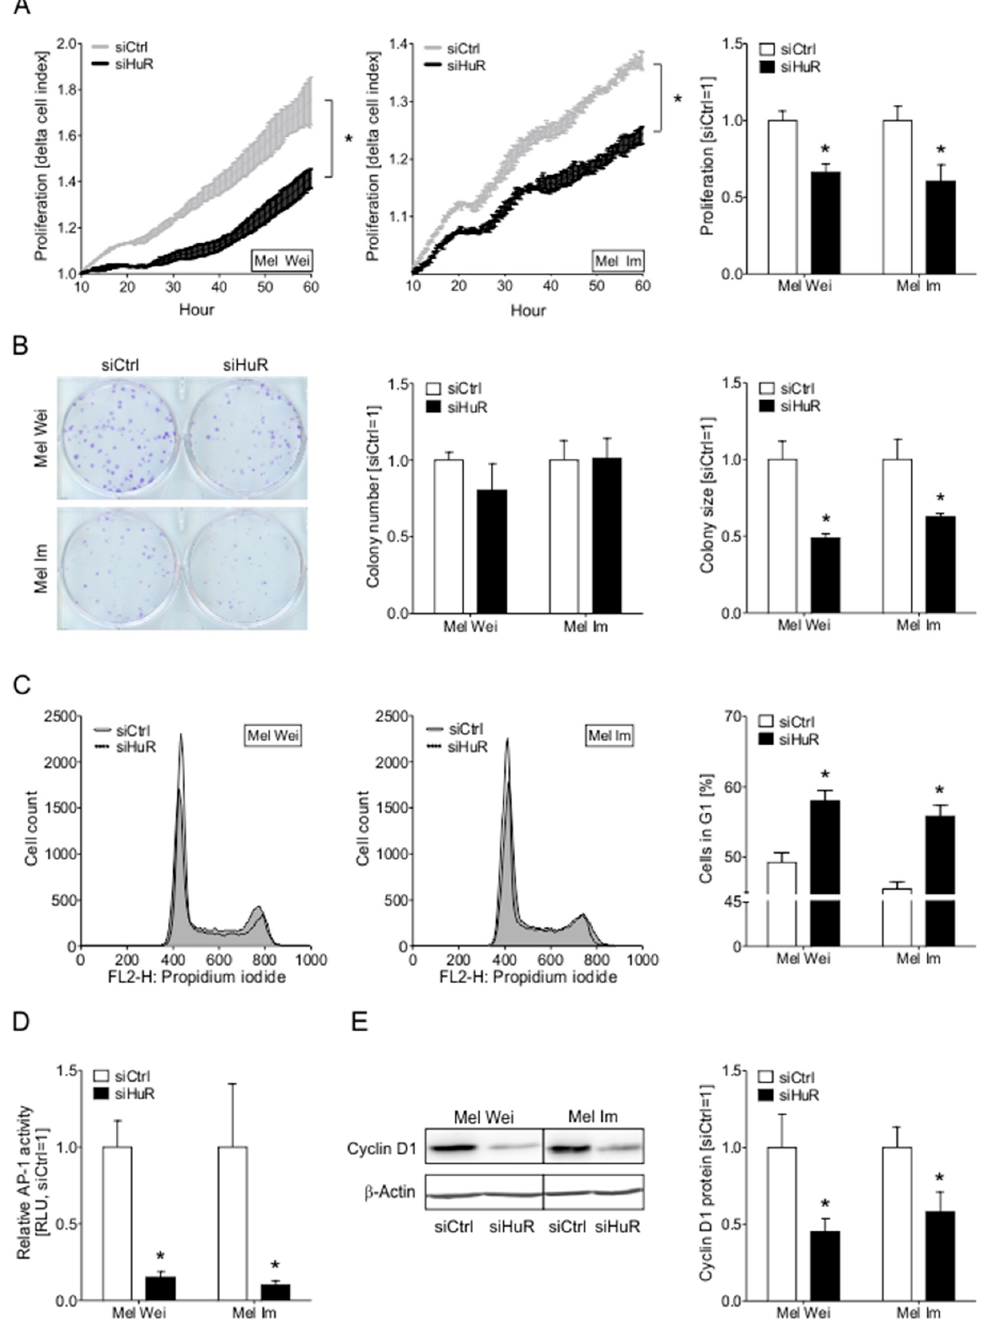
Figure 4. Influence of HuR knockdown on the proliferative capacity of melanoma cells in vitro . ( A ) Exemplary real-time cell proliferation curves of Mel Wei and Mel Im cells (left panel) and quantified ‘slope’ (proliferative ability, siCtrl = 1) (right panel). ( B ) Exemplary images of anchorage-dependent clonogenic assays of Mel Wei and Mel Im cells (left panel) and quantification of colony number and size (right panel) in these cells (siCtrl = 1). ( C ) FACS-based cell cycle analysis of Mel Wei and Mel Im cells. Depicted are representative overlays of cell cycle histograms (left panel) and percentages of G1 cell cycle fractions (right panel) in these cells (siCtrl = 1). ( D ) Luciferase AP-1-reporter activity in siCtrl and siHuR transfected melanoma cells (siCtrl = 1). ( E ) Densitometric quantification (right) and exemplary image (left) of Western blot analysis of Cyclin D1 protein levels in transfected Mel Wei and Mel Im cells (siCtrl = 1). *A p -value of <0.05 was considered statistically significant. The uncropped blots and molecular weight markers of Figure 4E are shown in Figure S8.